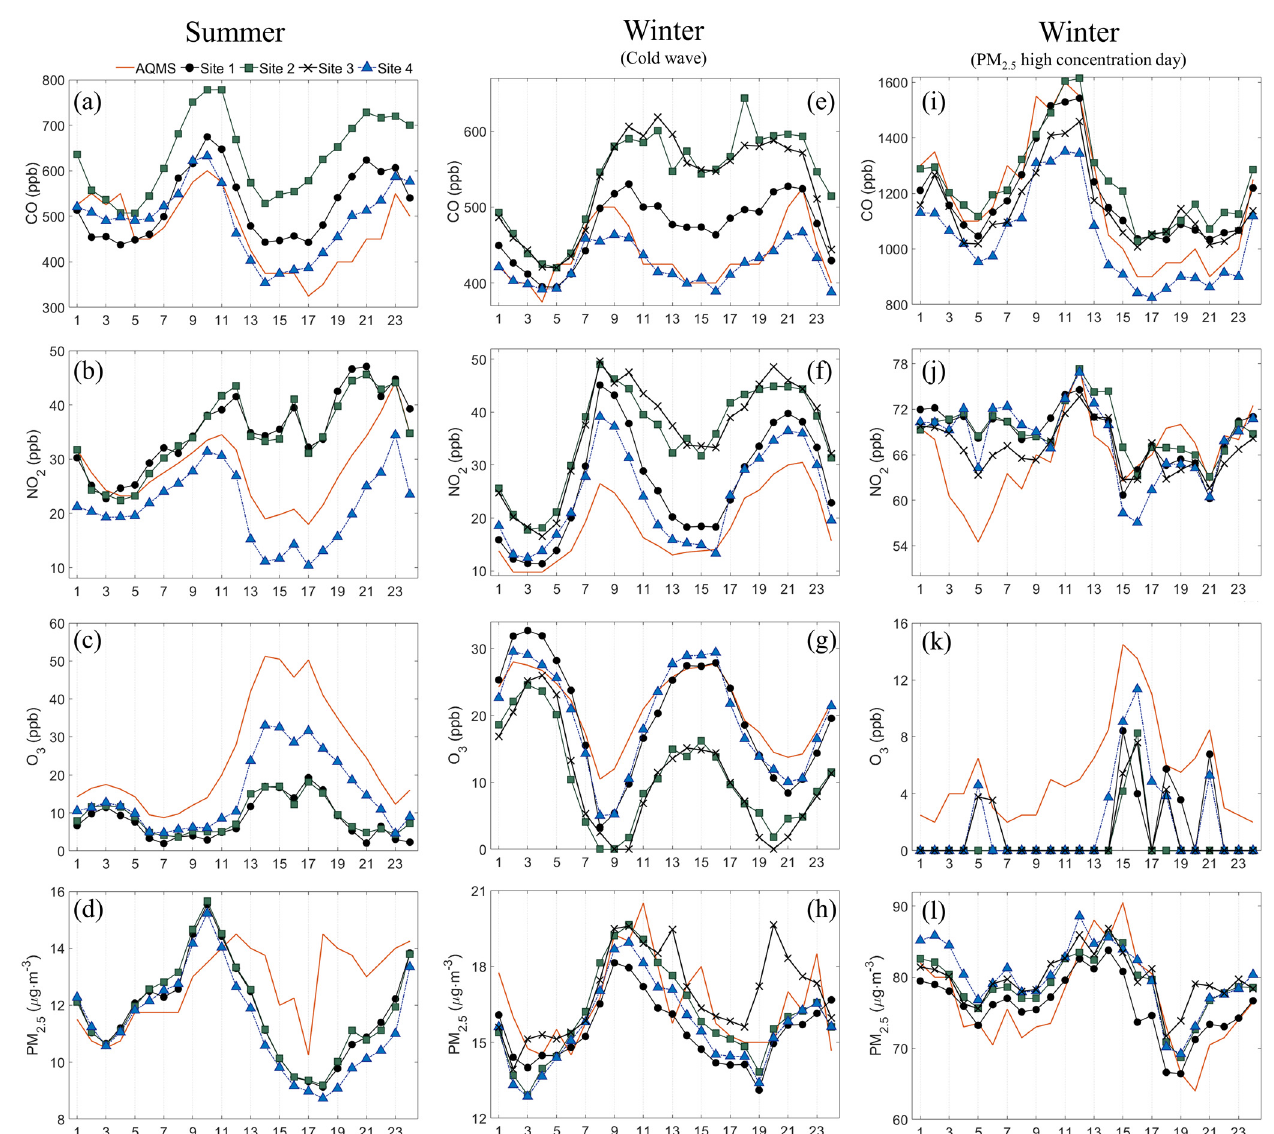
Figure 6. Weekday diurnal variations of air pollutants at each sub-site (black circles: Site-1, green squares: Site-2, black x: Site-3, blue triangles: Site-4, and orange line: the AQMS). The left panel shows the diurnal variations in summer ( a – d ), the middle panel shows the cold wave period ( e – h ), and the right panel shows the PM 2.5 pollution event in winter ( i – l ).